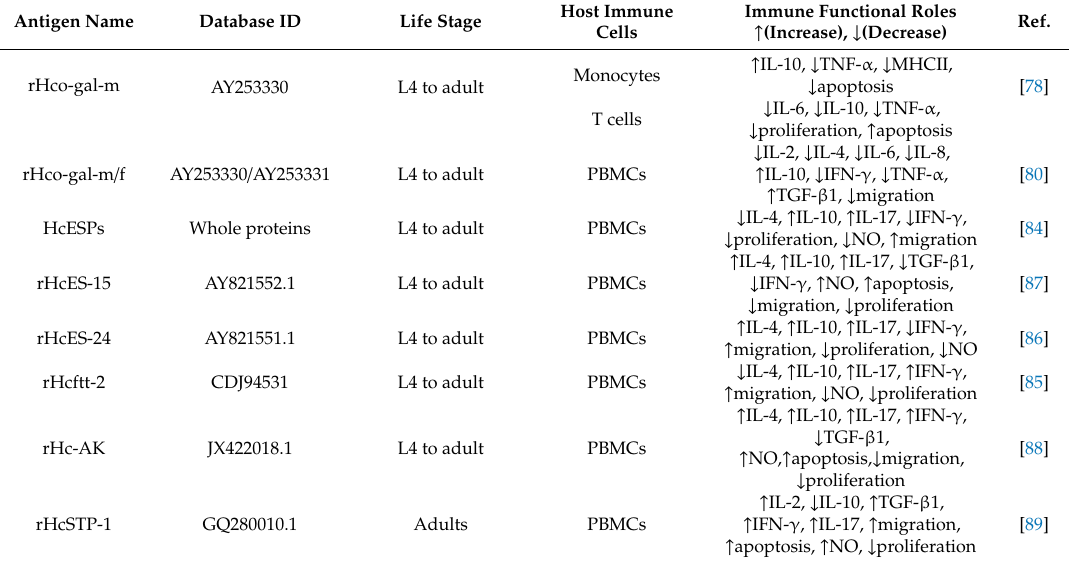
Table 1. Immunoregulatory dynamics of di ff erent Haemonchus contortus excretory / secretory proteins (HcESPs) after binding to host immune